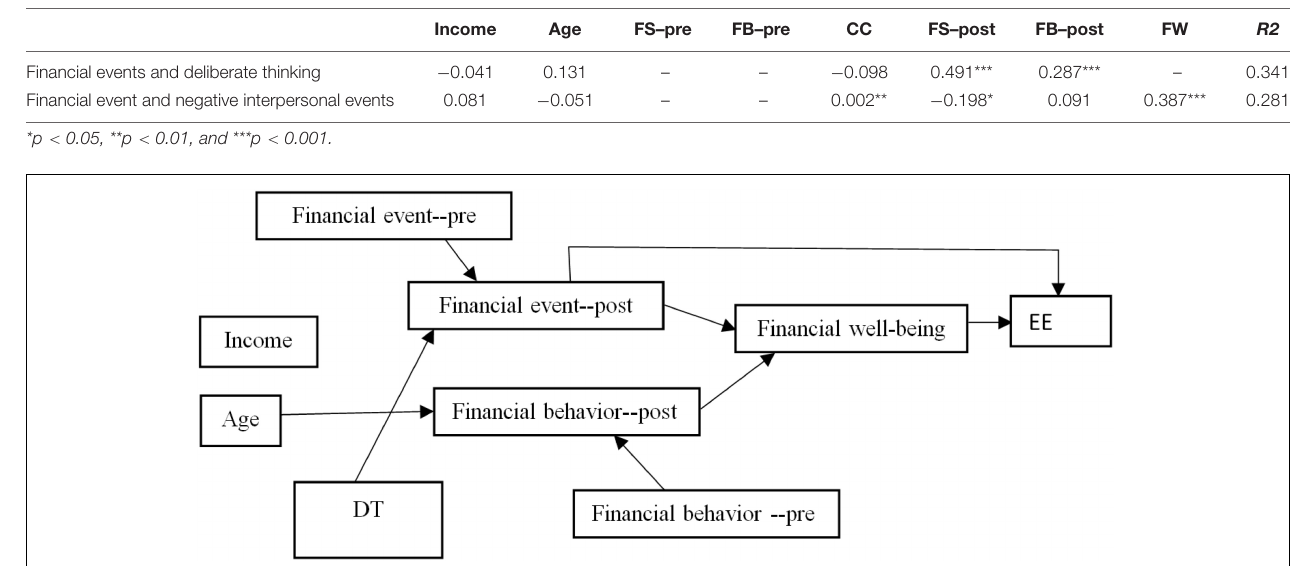
TABLE 5 | Path analysis results of financial events, deliberate thinking and negative interpersonal events.